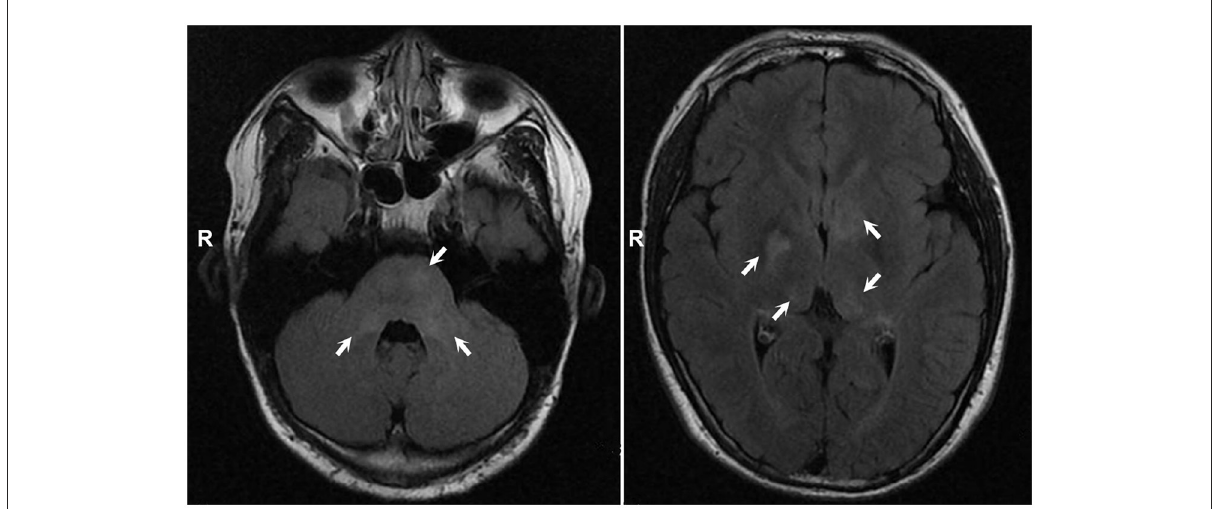
FIGURE2 MRI showed multiple abnormal signal foci in bilateral basal ganglia, thalamus, and pons.